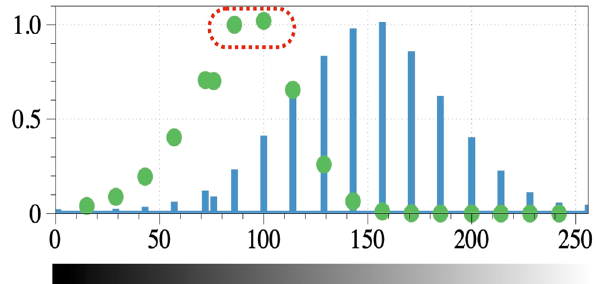
Figure 9a is an image containing NPs, BC, and other artifacts.